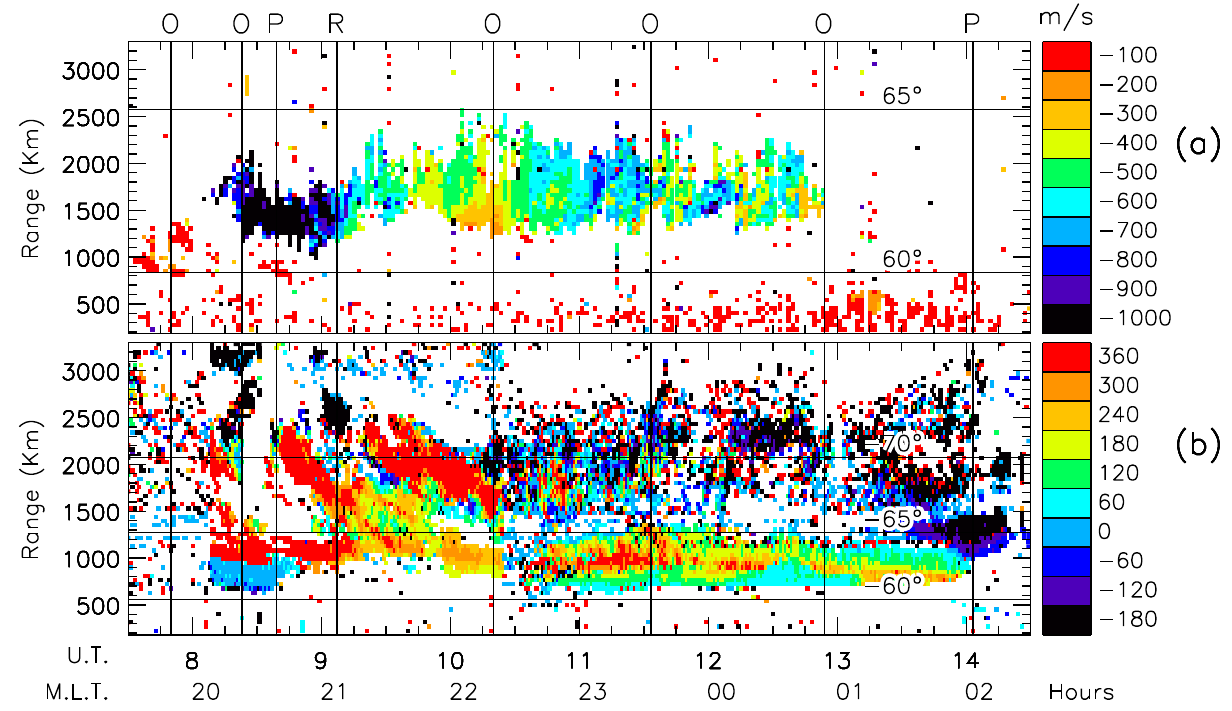
Fig. 7. (a) Range-time plot of the LOS Doppler velocity (m s − 1 ) measured on King Salmon (KGS) beam 2 during 07:30 to 14:30 UT on 30 November 2002. (b) The same measured on TIGER beam 14. Thin vertical lines represent the same substorm phases shown in Fig. 1. Thin, black, horizontal lines represent magnetic latitudes and abscissas have tick marks at 15-min intervals of UT. Nominal values of MLT above MQI are also